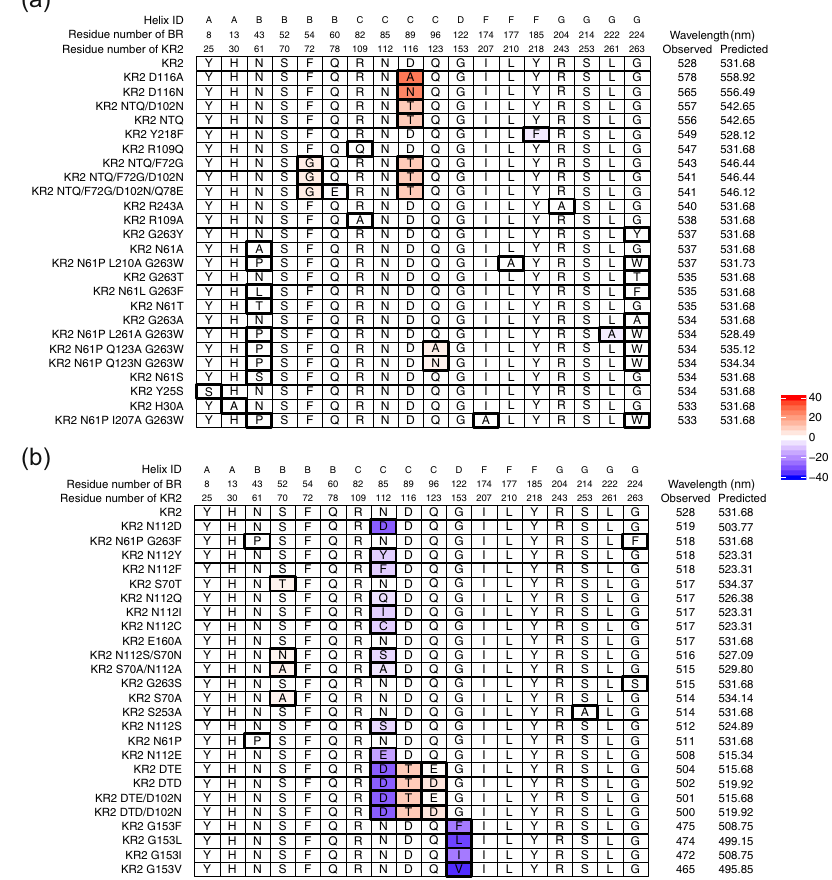
Figure 7. Lists of sequences for the KR2 wildtype and the variants with their observed and predicted absorption wavelengths. ( a ) KR2 and the 25 variants that have the longest observed wavelengths, and ( b ) KR2 and the 25 variants that have the shortest observed wavelengths. The residues shown here are replaced at least once among the 50 variants. Boxes with thick black lines indicate positions that have different amino-acid species from the KR2 wildtype. For these boxes, the colour indicates the wavelength change produced by the replacement of the j -th position, estimated by ,(KR2) , where x representation the KR2 wildtype and a variant,